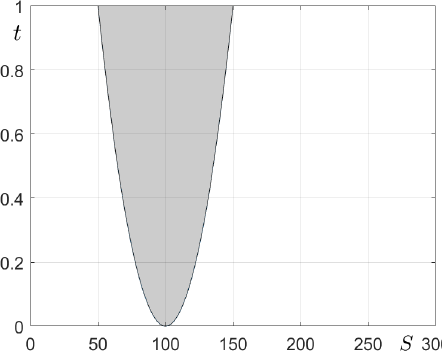
Figure 4. Schematic diagram of the effective volatility region.